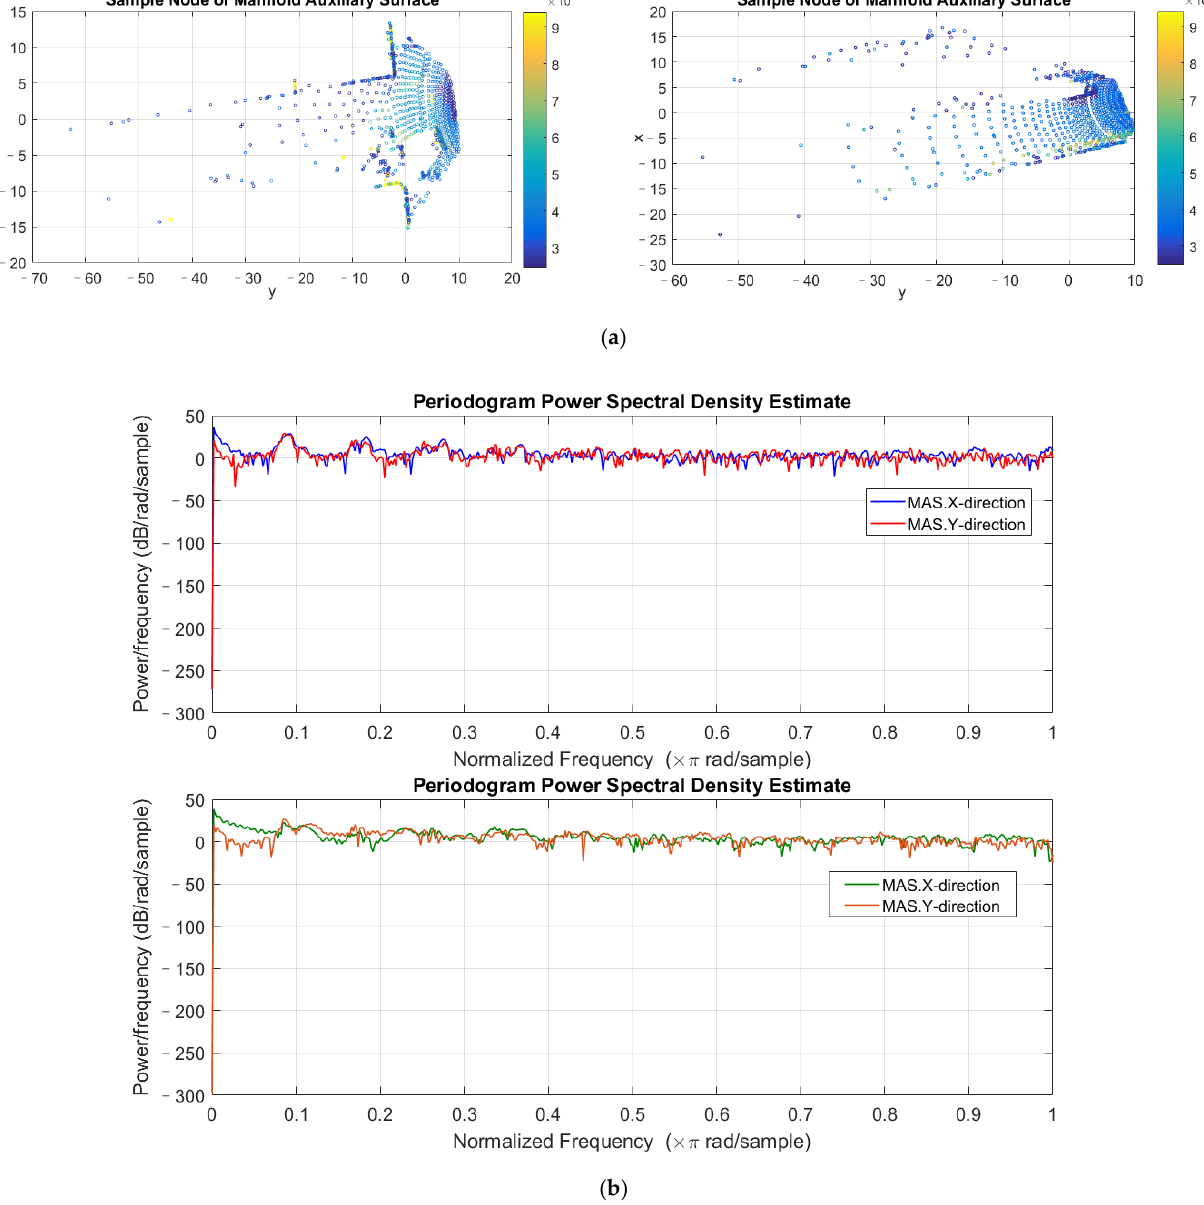
Figure 5. Mapping results of MAS. ( a ) The point mapping; ( b ) Power spectra in different directions.